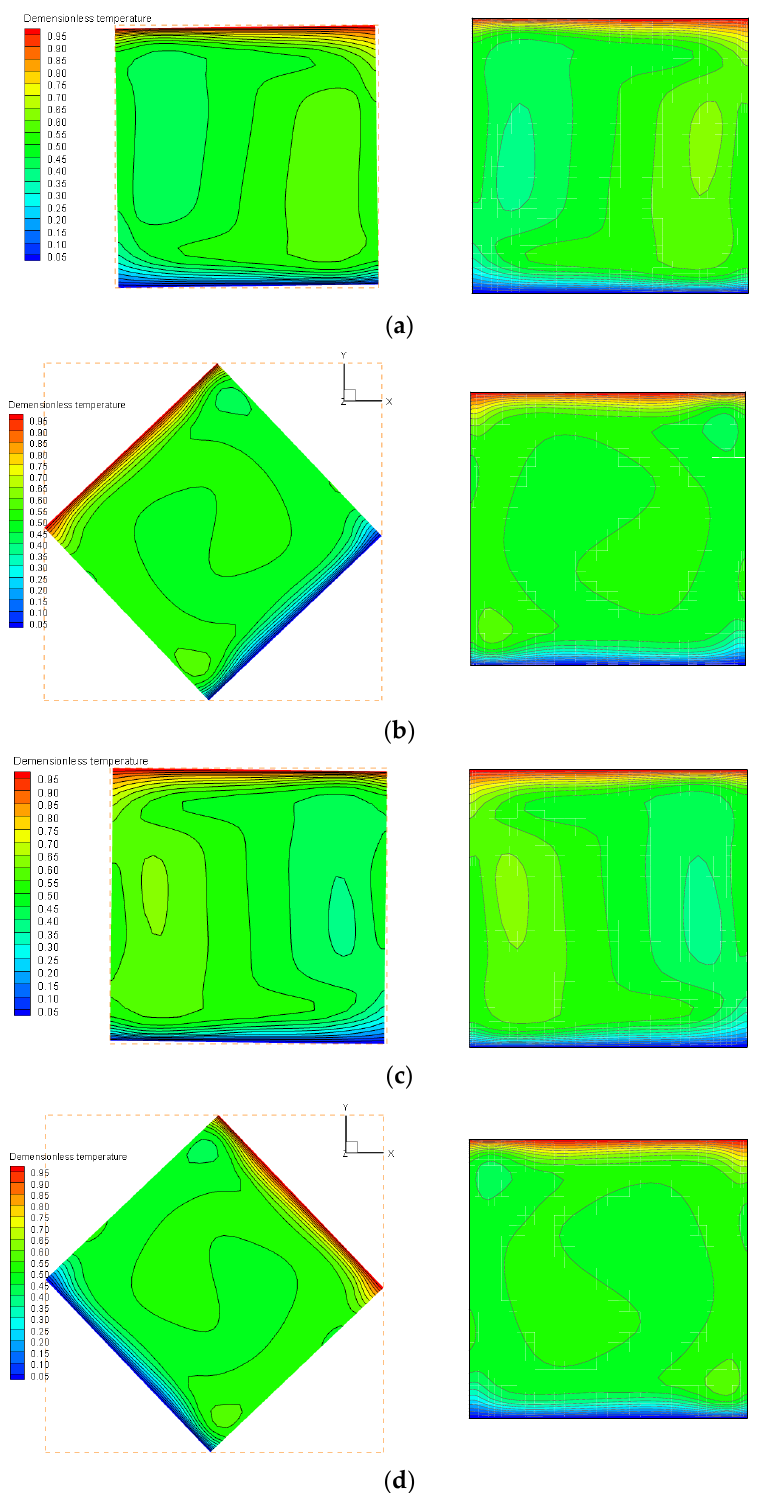
Figure 4. Comparison between code results ( right ) and Ansys-Fluent results with Dynamic mesh ( left ) with Ra = 10 6 and t c = 1s: ( a ) ϕ = 0 (+) ; ( b ) ϕ = ϕ m ; ( c ) ϕ = 0 ( − ) ; ( d ) ϕ = − ϕ m